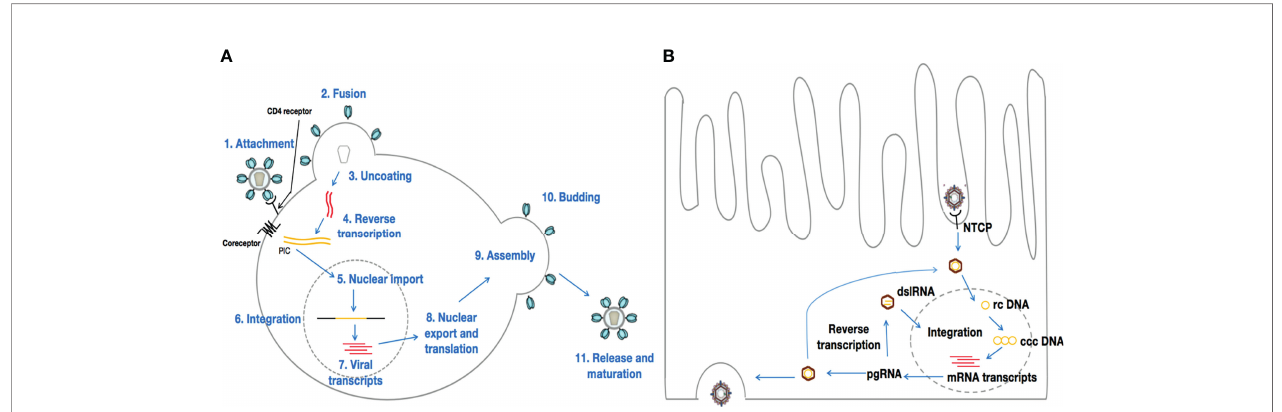
FIGURE 1 | Life cycles of HIV and HBV. (A) represents HIV life cycle once in contact with CD4+ T-cells. Although HIV preferentially infects CD4+ T-cells, HIV tropism is not limited to CD4+ T-cells only. Conversely, HBV [the life cycle of which is depicted in (B) ] infects hepatocytes